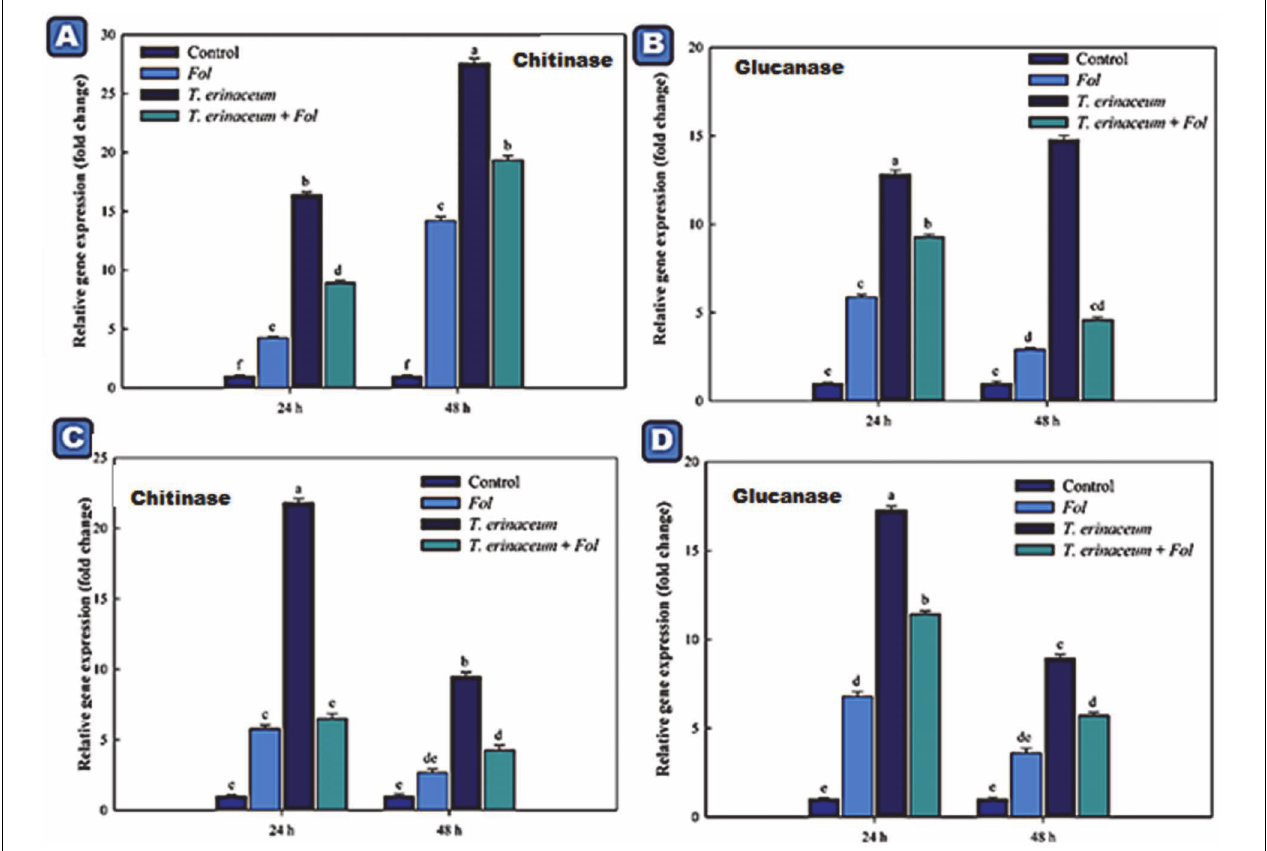
FIGURE 6 | Quantitative PCR results showing the tissue specific differential expression of the genes encoding PR proteins (Chitinases and Glucanases) expressed in the root and leaf tissues and were measured at different time intervals (0, 24, and 48 h). The data represents the relative fold changes in the expression values for the four different treatments. (A) The expression profile of chitinase encoding gene ( CHI1 ) expressed in the leaf tissues. (B) The expression profile of the glucanases encoding gene expressed in the leaf tissues. (C) The expression profile of the chitinase encoding gene in the root tissues. (D) The expression profile of the glucanase encoding gene in the root tissues and were measured at different time intervals. Bars with distinct alphabetical letters are significantly different at P ≤ 0.05 using the DMRT